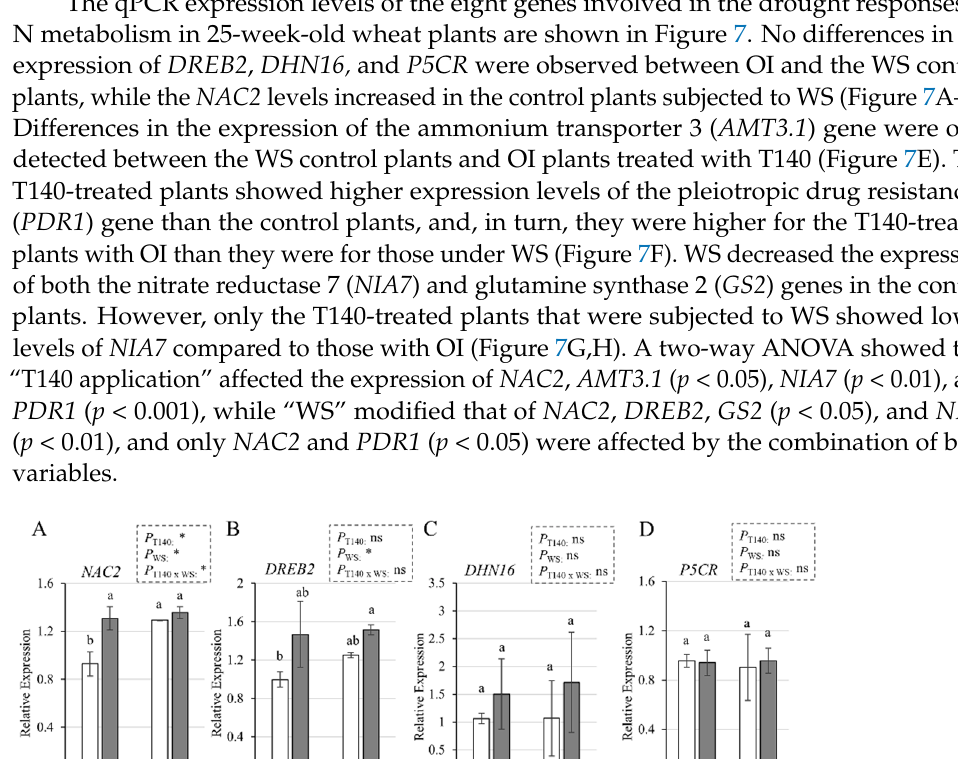
Figure 6. Effect of T140 application, water stress (WS, 1/2 watering applied), and the combination of both on the macro- and microelement contents of wheat grains harvested in the greenhouse assay 28 weeks after sowing. The heat map is colored according to the significance degree (–log P -value), with darker green indicating a higher increase and darker red indicating a greater decrease in the content. Data are calculated from five replicates per each treatment and irrigation condition ( n = 5).